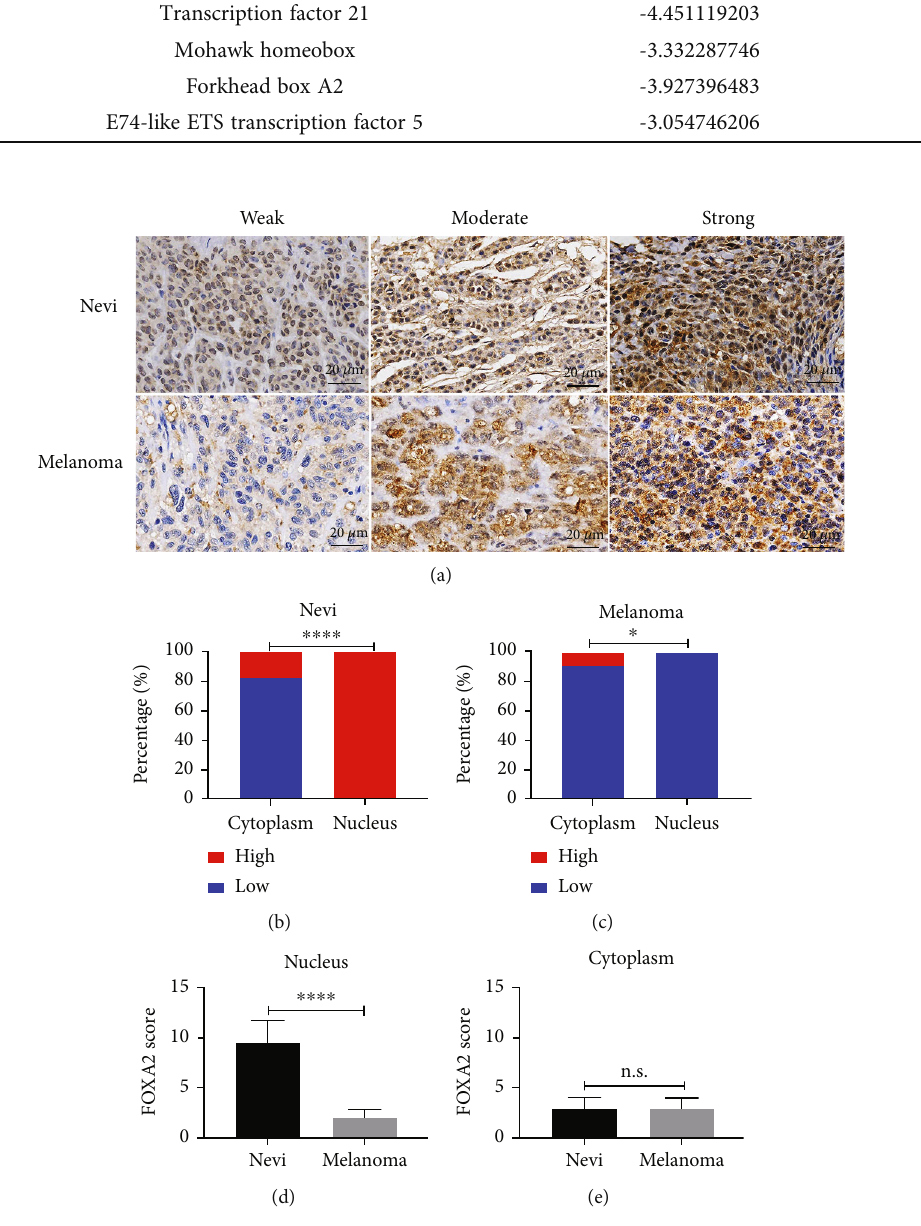
Figure 5: Immunohistochemical staining of FOXA2 in nevi and melanoma tissues. (a) Representative images of IHC staining for FOXA2 in nevi ( n = 11 ) and melanoma ( n = 67 ). FOXA2 staining was stronger in nevi cells and was located mainly in the nucleus. Staining was weaker in melanoma tissues and was located primarily in the cytoplasm. (b, c) Percentage of nevi and melanoma tissues with high or low FOXA2 expression in the cytoplasm and nucleus. (d, e) IRSs of FOXA2 staining in nevi and melanoma tissues. Scale bars = 20 μ m. ∗ p < 0 : 05 , ∗∗∗∗ p < 0 : 0001